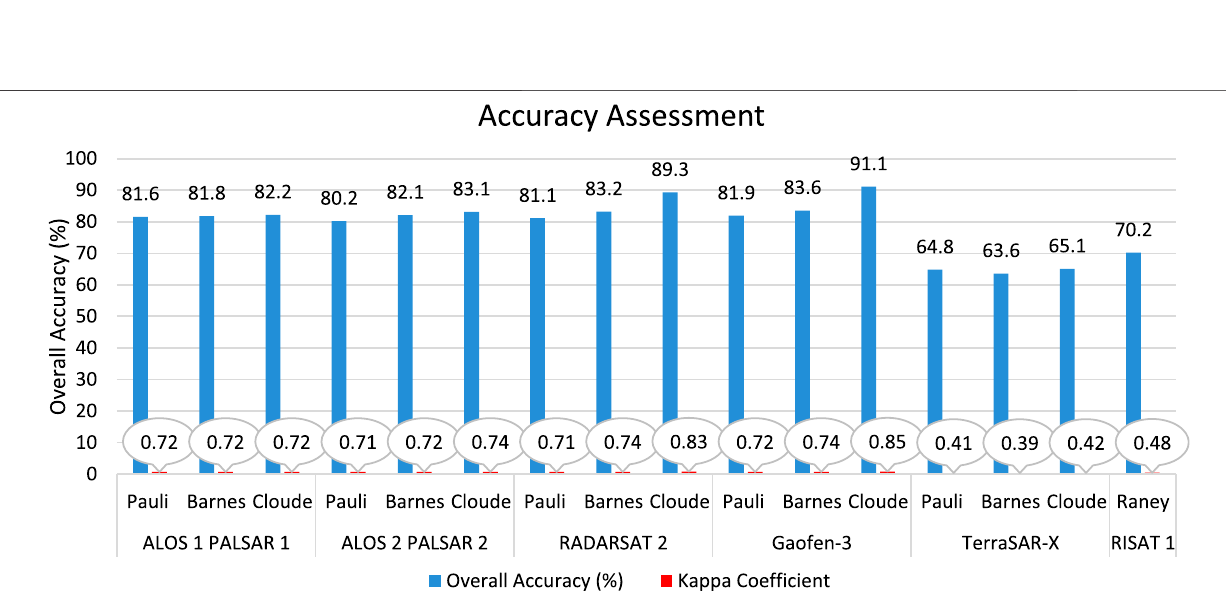
Frontiers in Earth Science |